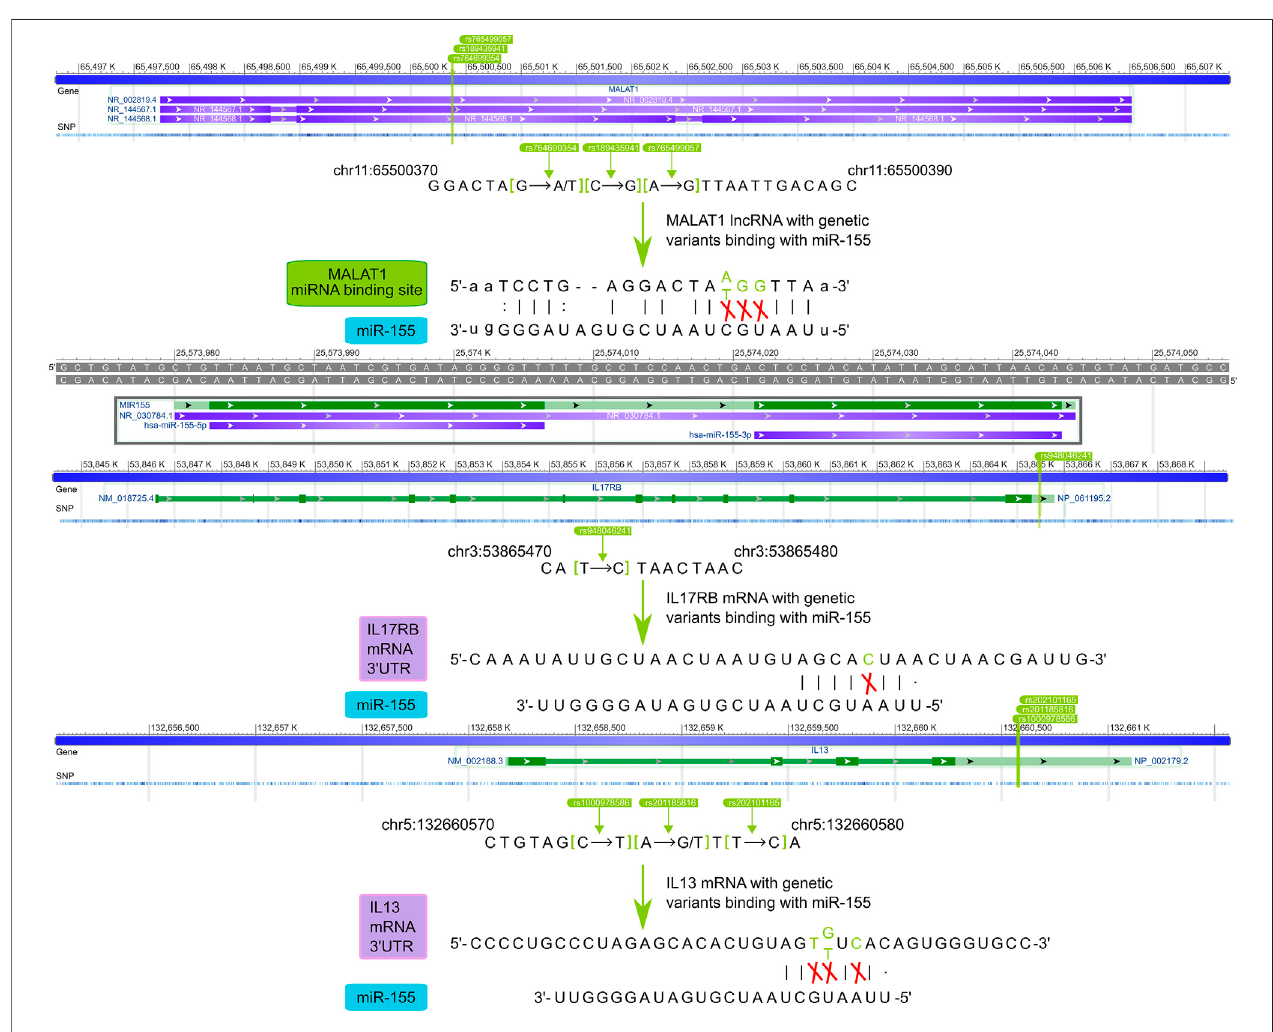
FIGURE 6 | The potential mechanisms of regulatory SNPs in fl uence IL13 and IL17RB via ceRNA regulation.